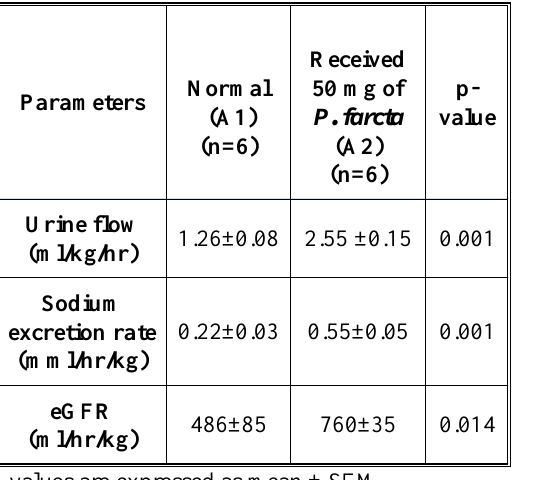
Table 2. Effects of P. farcta fruit decoction 50mg/Kg on urine flow, sodium excretion rate, and eGFR in normal rats